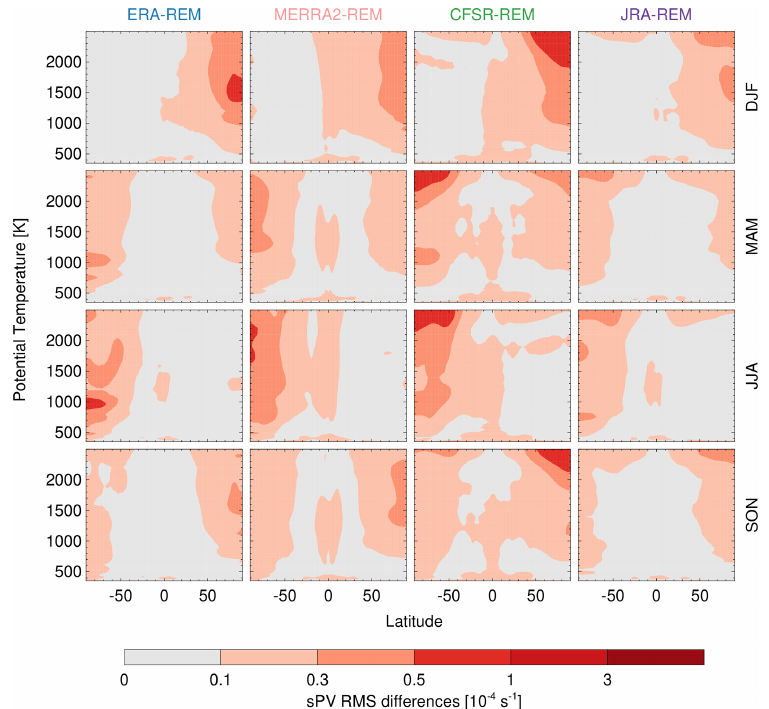
Figure A1. Seasonal root-mean-square (RMS) daily (1980–2014) sPV differences.